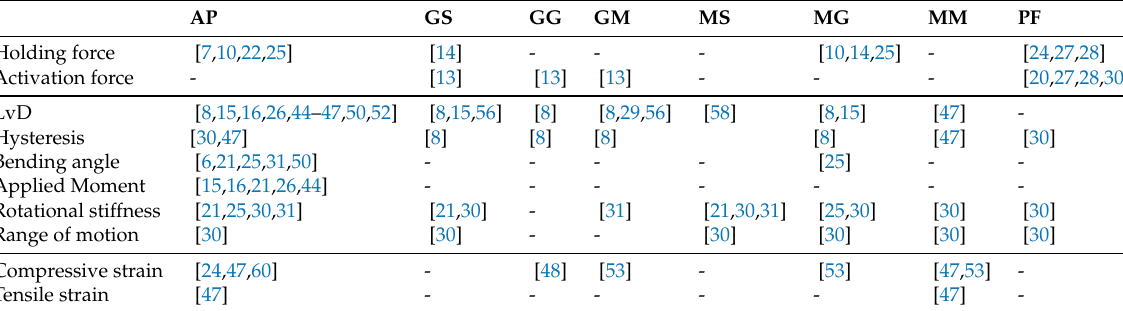
Table 10. Frequency of varying granular jamming parameters per metric.